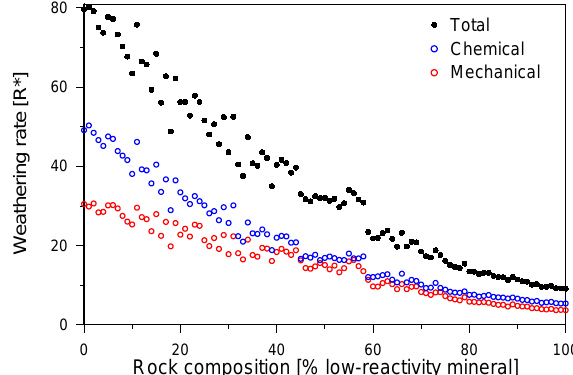
Figure 4. Impact of rock composition on weathering rate. The over- all weathering rate (full black circles) decreases with the addition of low-reactivity minerals to the rock. Chemical weathering (hollow blue circles) shows a disproportionally large decrease with a small addition of low reactive phases. Mechanical weathering (hollow red circles) shows a more uniform decrease with the change in the rock composition, indicating that the main factor controlling the overall weathering rate is the chemical weathering